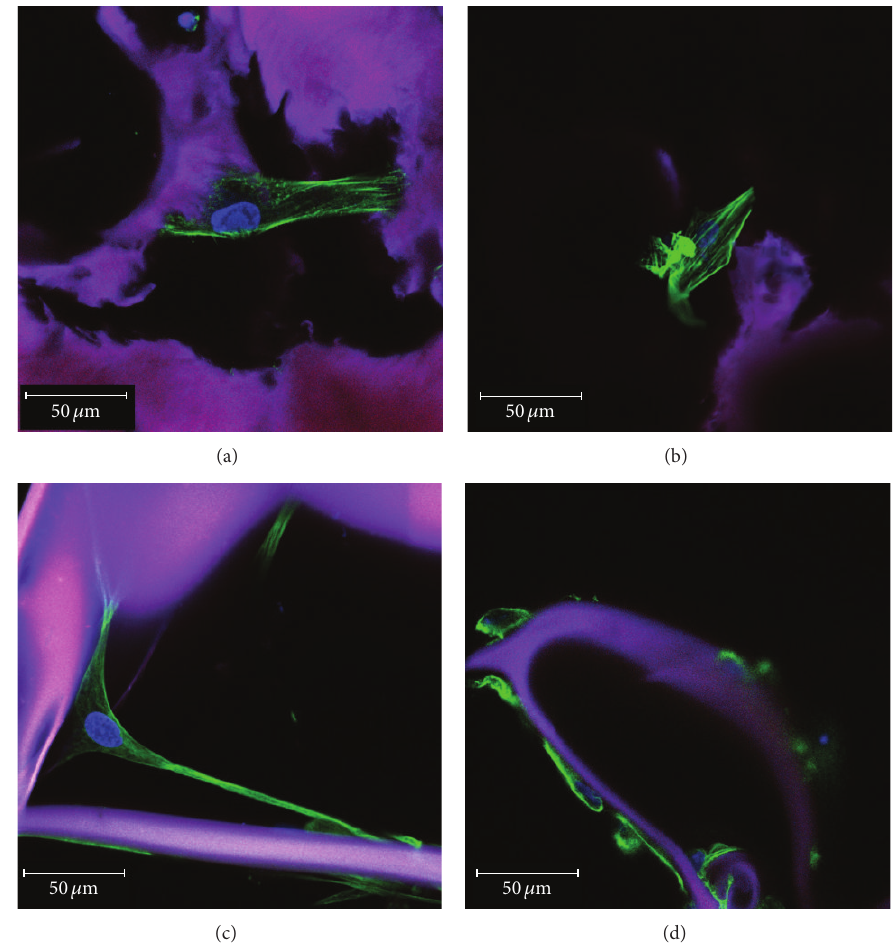
Figure 3: Confocal fluorescence microscopy micrographs of hADSCs actin filaments and tubulin network in hADSCs/G-A-PAA biohybrid ((a), (c)) and in hADSCs/G-A control ((b), (d)). Matrix autofluorescence is seen in purple; DAPI-stained nuclei are